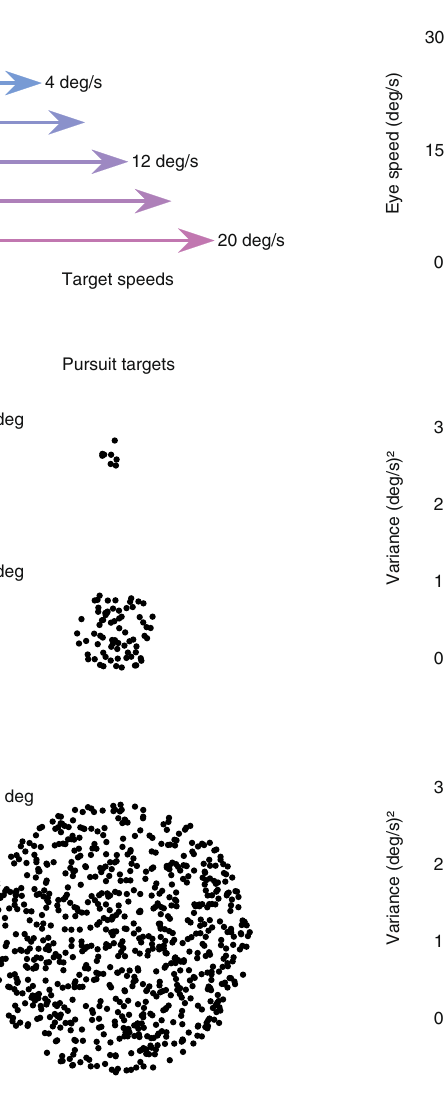
section; fi xed w vs. fl exible w : Monkey X, left pursuit: RMSE = 0.89 vs. 0.76 (deg/s) 2 , p = 0.05, t (499) = 1.68; Monkey X, right pursuit: RMSE = 0.63 vs. 0.27 (deg/s) 2 , p = 0.01, t (499) = 2.20; Monkey R, left pursuit: RMSE = 0.35 vs. 0.21 (deg/s) 2 , p << 0.01, t (499) = 3.89; Monkey R, right pursuit: RMSE = 0.46 vs. 0.22 (deg/s) 2 , p << 0.01,